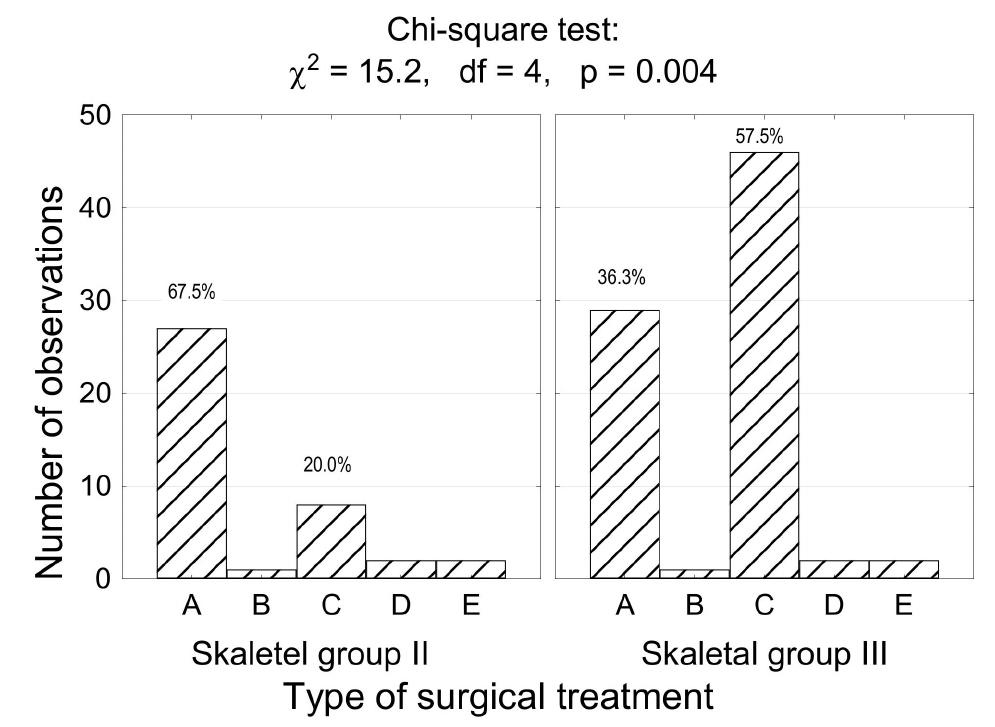
Figure 7. The number (percentage) of patients in the groups with different skeletal classes and types of surgical treatment, and the result of the chi-squared test. A—one jaw surgery, B—one jaw +